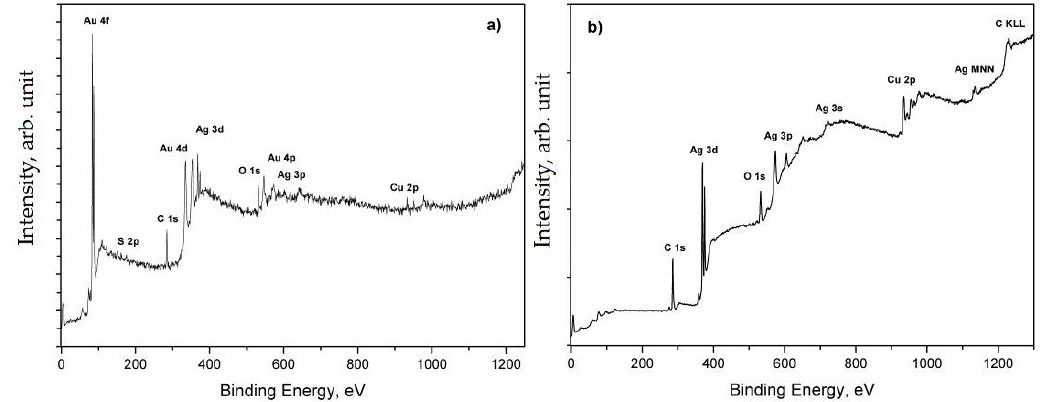
Figure 2. XPS survey scans of the gold ( a ) and silver ( b ) coins.